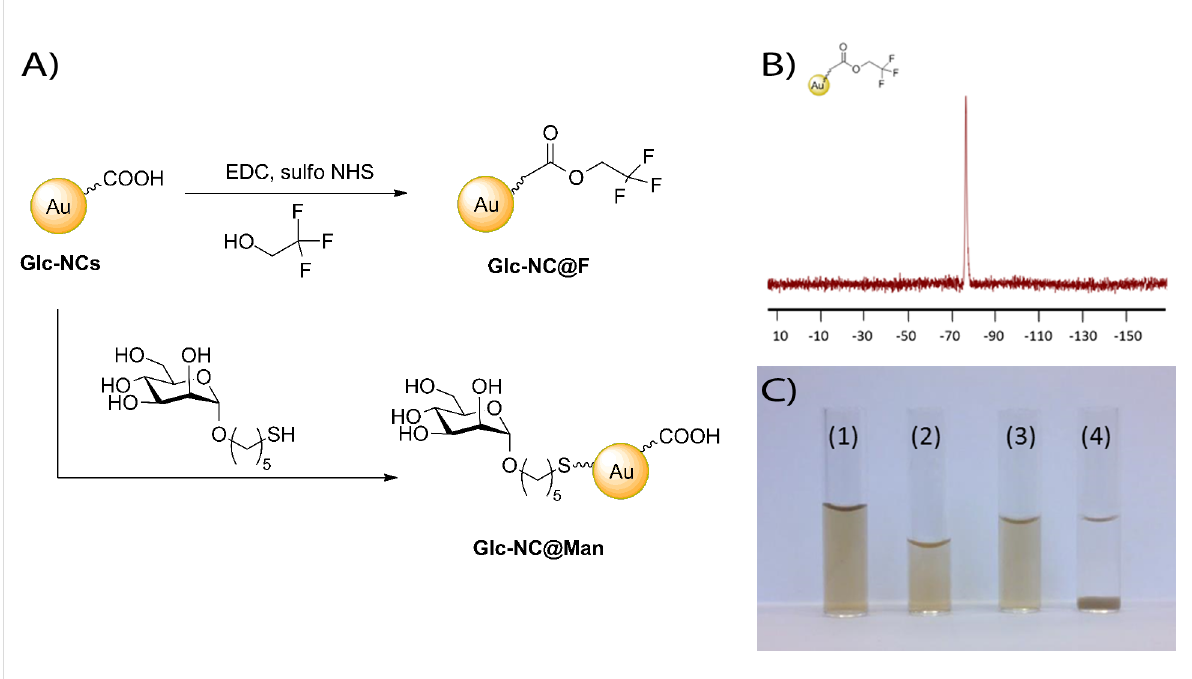
Figure 2: A) Functionalization of Glc-NCs by coupling trifluoroethanol to the carboxylic acid groups on the surface of the nanocluster to yield Glc- NC@F and via thio-substitution of pentylthiol mannoside on the gold surface giving Glc-NC@Man ; B) 19 F NMR of Glc-NC@F after dialysis showing one product peak; C) vials containing (1) Glc-NCs (2) Glc-NC@Man (3) Glc-NCs + ConA (4) Glc-NC@Man + ConA. Aggregation is only observed upon addition of the lectin ConA